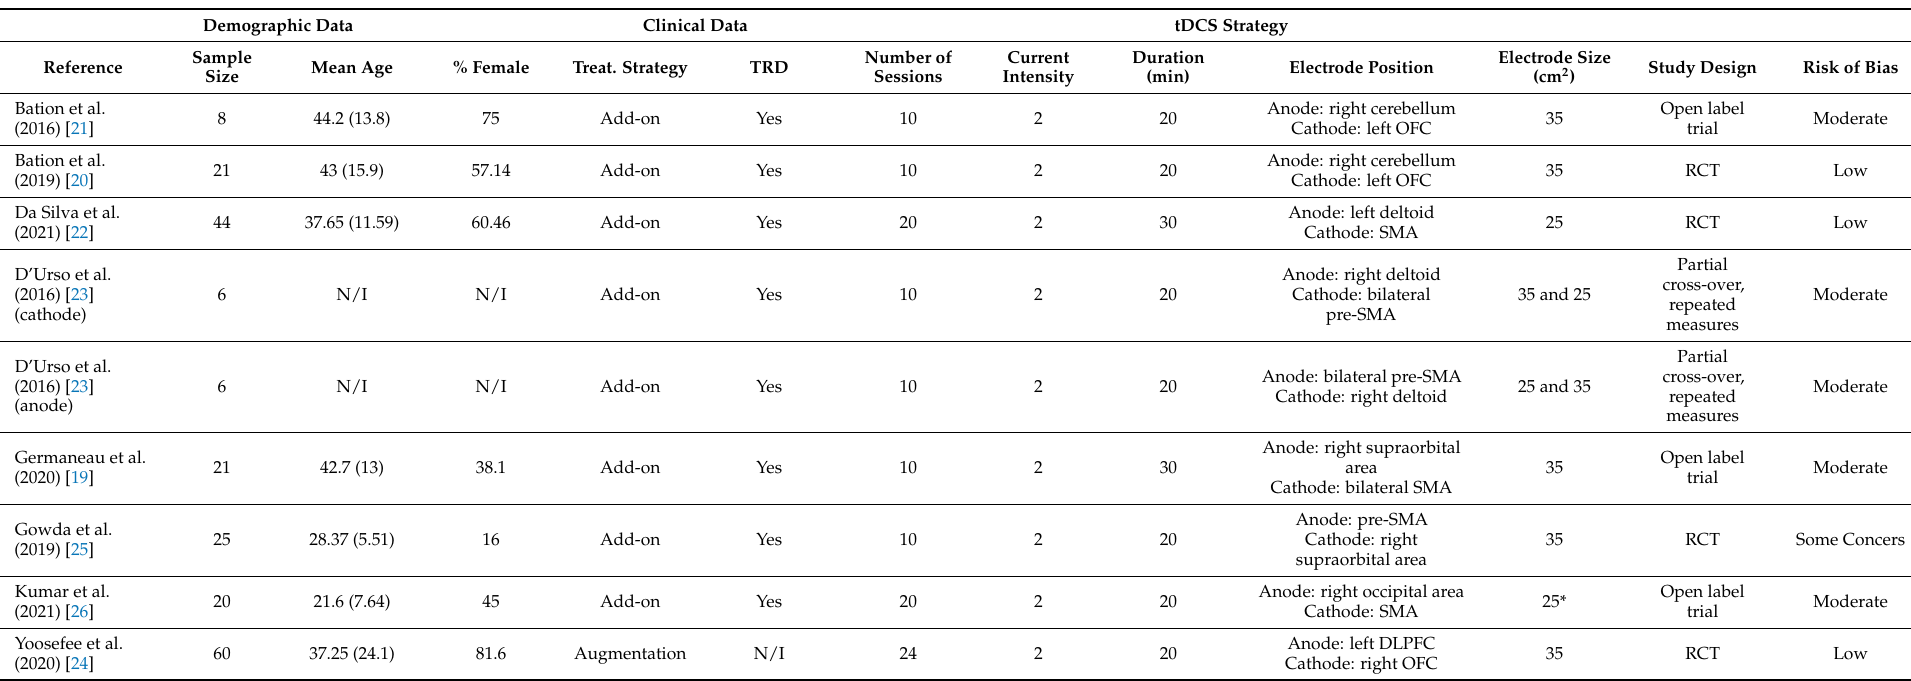
Table 1. Summary of the included